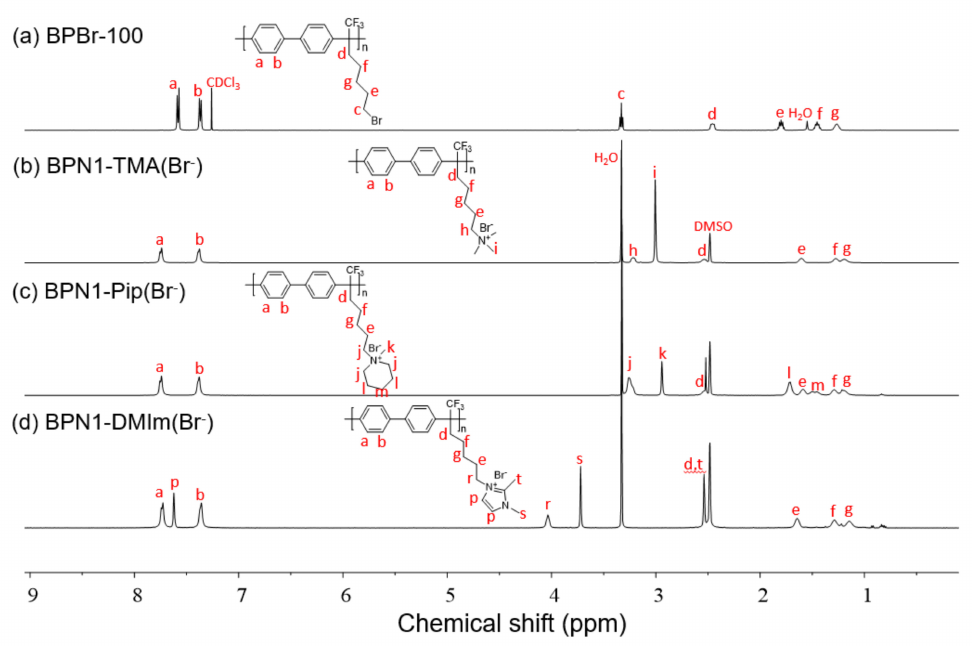
Figure 2. 1 H NMR spectra of ( a ) BPBr-100; ( b ) BPN1-TMA(Br − ); ( c ) BPN1-Pip(Br − ); and ( d ) BPN1- DMIm(Br −